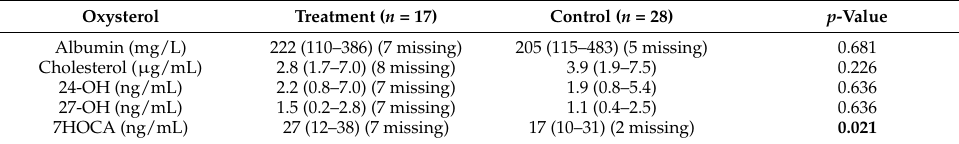
Table 3. Post-operative metabolites in the treatment group vs. non-treated